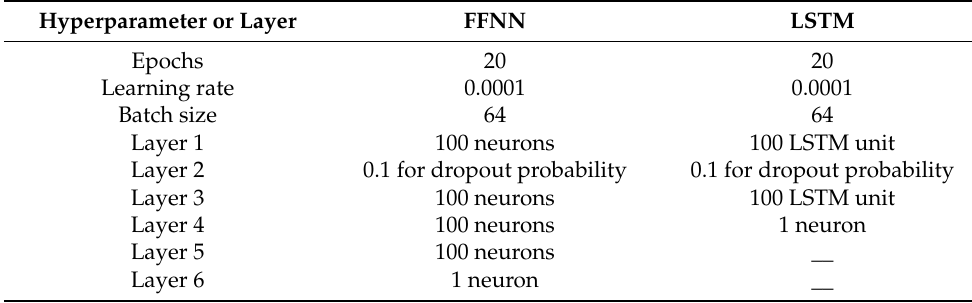
Table 4. Hyperparameters used during the training of FFNN and LSTM